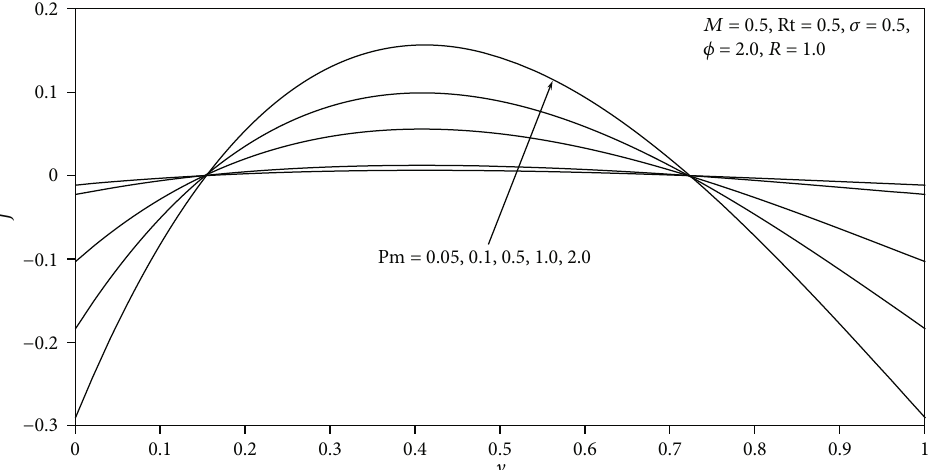
Figure 12: Induced current density for di ff erent values of the magnetic Prandtl number Pm .